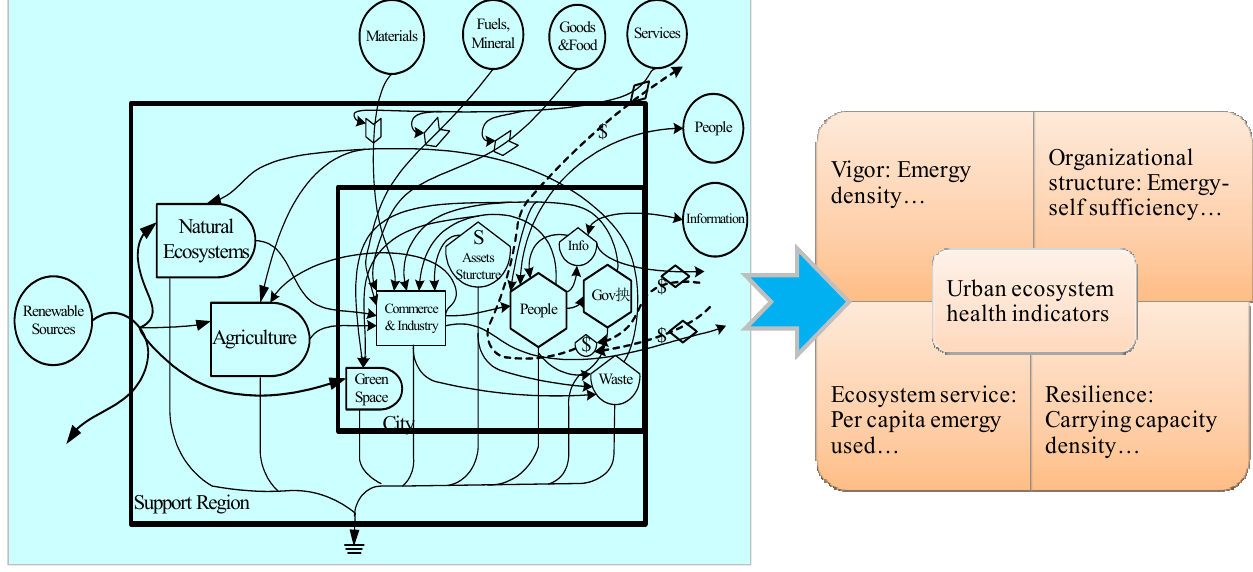
Figure 3. Sketch of the eco-thermodynamics model of urban ecosystem health assessment.